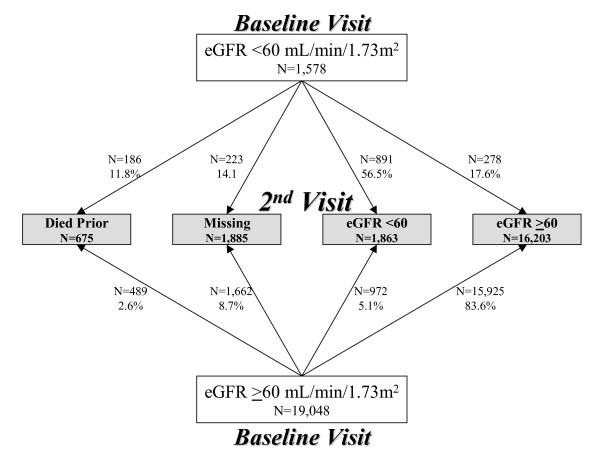
Transitions from the first to second study visit by baseline eGFR group. 'Missing' refers to participants either without second visit labs or without a second visit altogether.